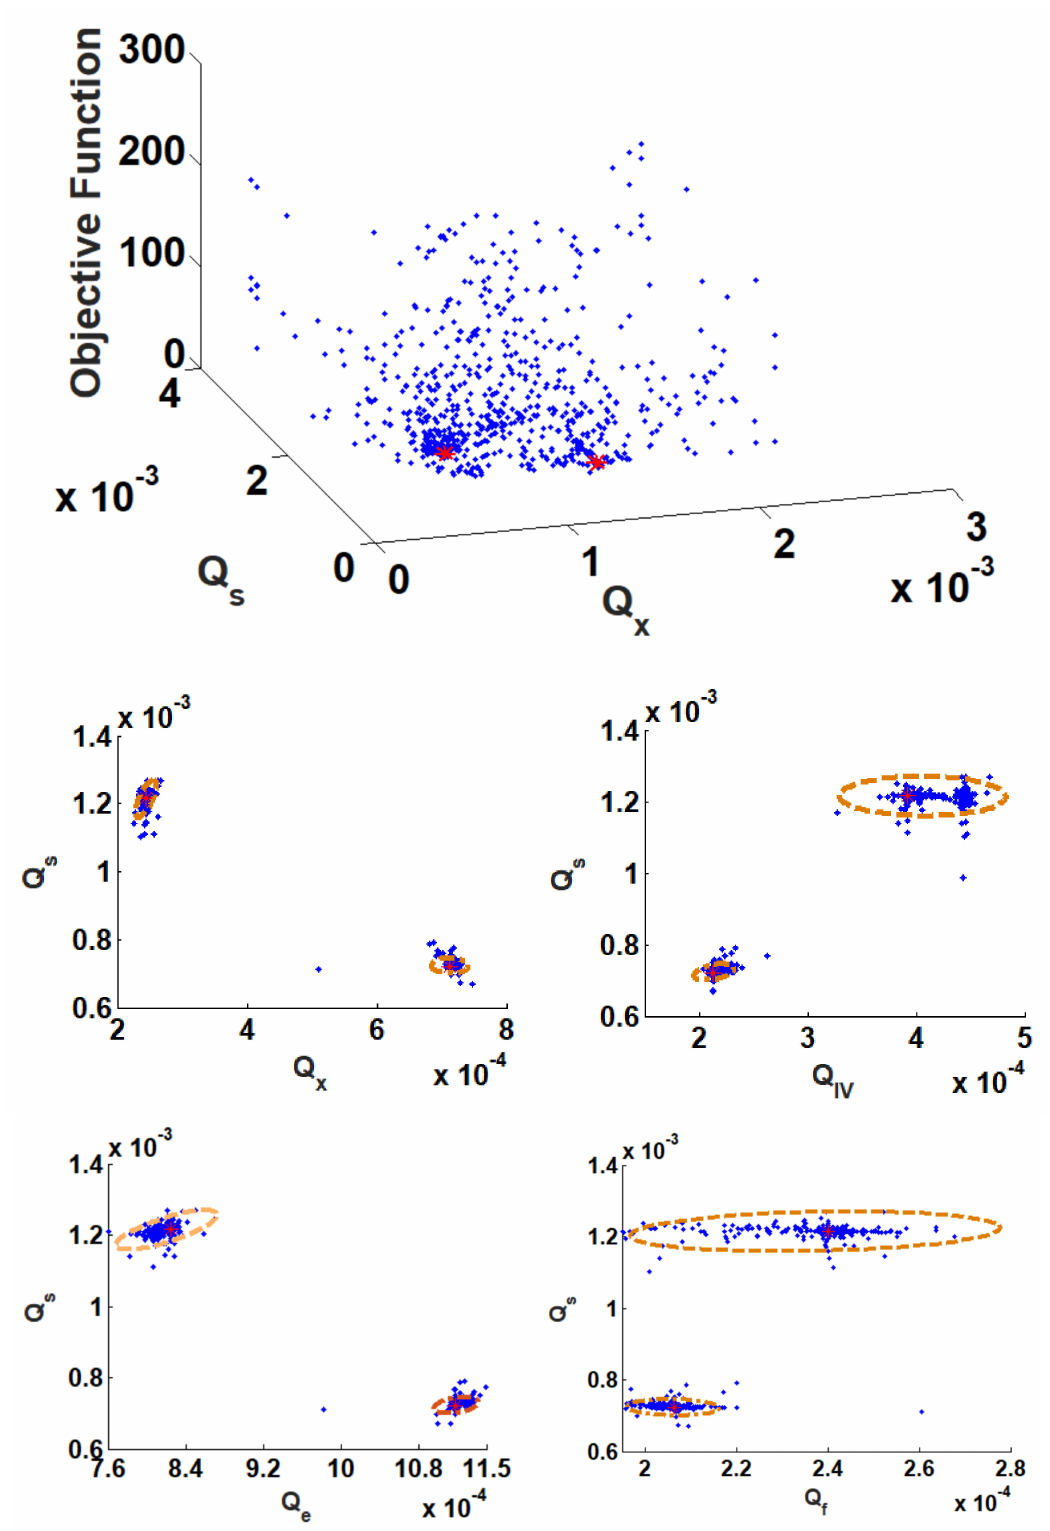
Figure 10. Process optimization results based on the proposed methodology. At the top of the figure is presented the objective function landscape, then it is presented the operating confidence region defined by the proposed test and the contour area where the local minima are